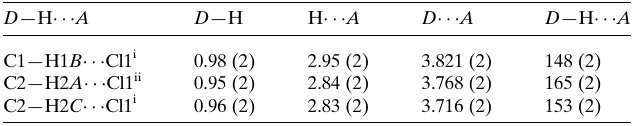
Table 2 Hydrogen-bond geometry (A˚ , (cid:4) ) for the tetragonal structure. D —H (cid:2)(cid:2)(cid:2) A